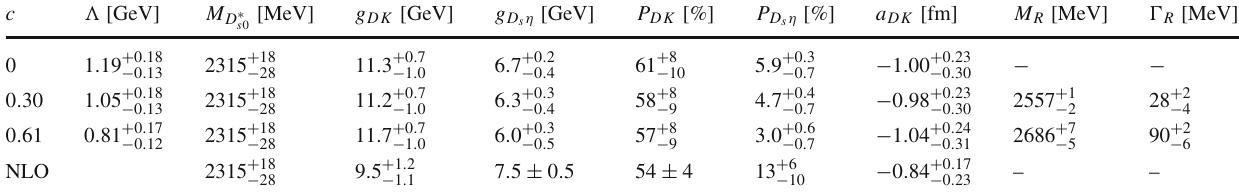
Table 5 Three different sets of c – (cid:4) pairs leading to the same we tune the UV cutoff to reproduce this mass. In this way, we determine ( 2317 ) mass (2315 + 18 D ∗ the error distributions of the cutoffs that are also used to estimate the − 28 ) obtained from the unitarized LO s 0 HMChPT+CQM approach. The UV cutoff (cid:4) is fitted to reproduce the uncertainties on the derived quantities (S-wave DK scattering length, above mass, that it is deduced from the unitarized NLO HMChPT T - mass and width of the higher–dressed–resonance, D ∗ ( 2317 ) mass, inherited from matrix [48]. The uncertainties in the D ∗ lar probabilities and couplings) given in the table. Predictions for the s 0 latter quantities from the unitarized NLO HMChPT approach [48,49] the errors on the LECs, are taken into account and lead to the errors on (cid:4) . We first generate synthetic sets of LECs, according to the correlated are compiled in the last row. Finally note that the choice c = 0 . 61 is error distributions given in Ref. [48]. Next, we find the position of the ( 2317 ) pole for each set of LECs, and finally, for each parameter c , D ∗ s 0